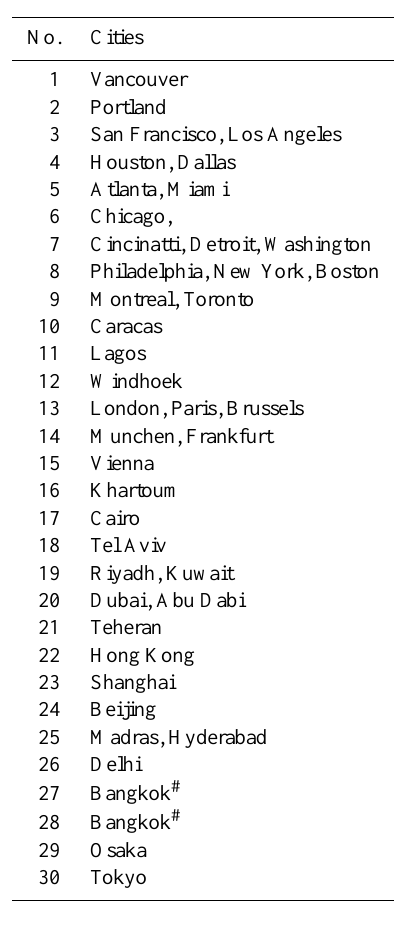
Table 2. Most frequently visited airports for which ascending of descending MOZAIC flights fall within the 8 ◦ × 8 ◦ grid box. # De- pending on the airport location, the direction or descending or as- cending MOZAIC flights can fall within different grid boxes, as is the case for